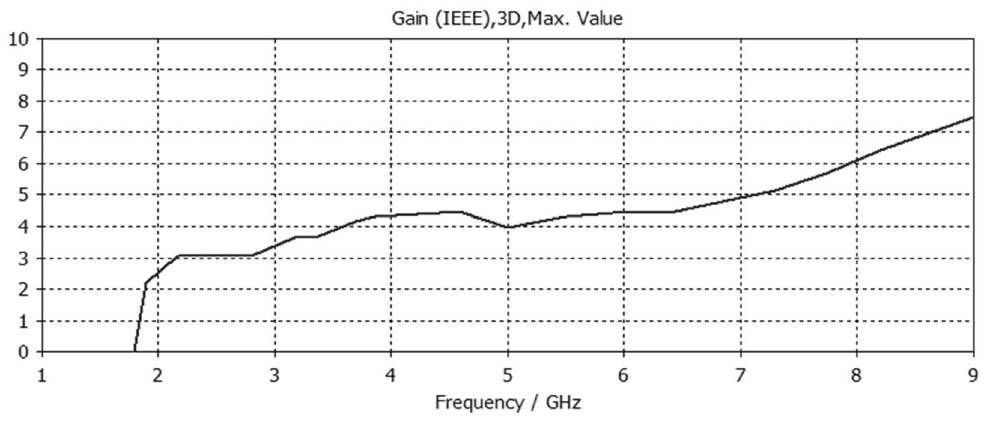
Figure 11. Gain result for